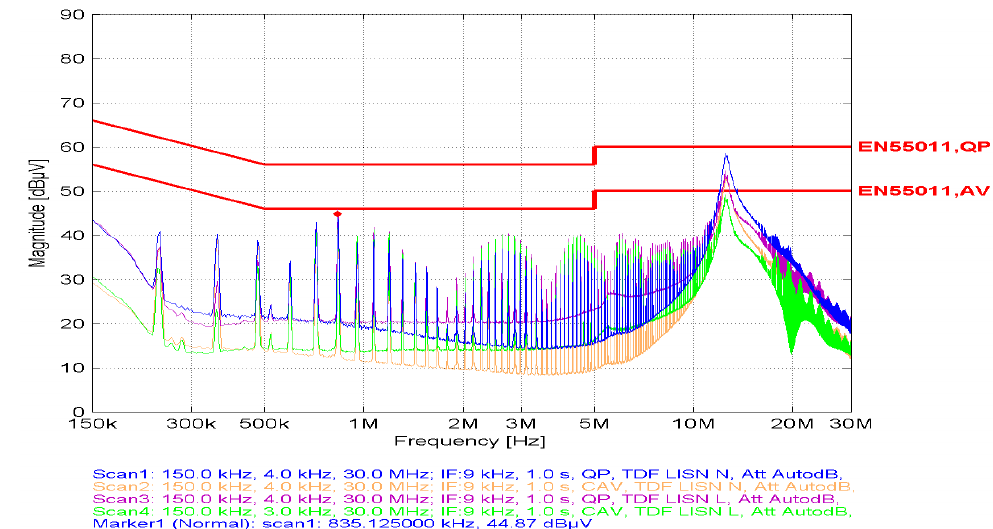
Figure 15. Attenuation level for ferrite No. 3 with the number of coils at 35